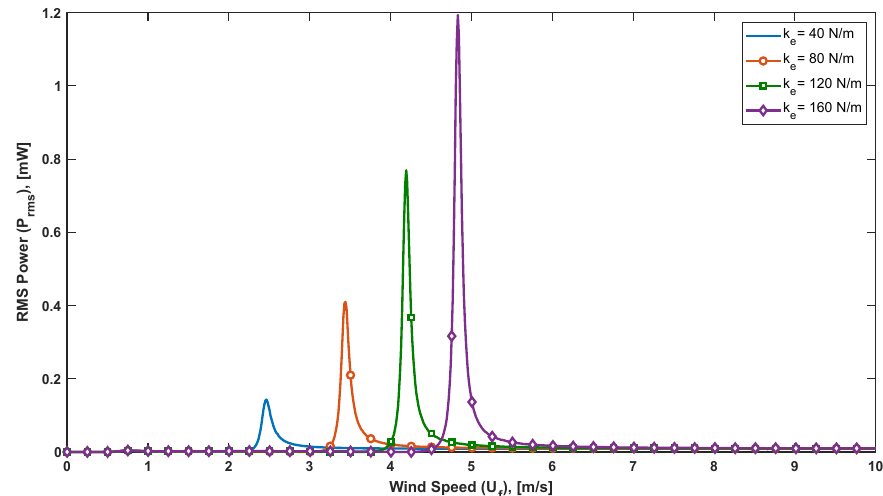
Figure 11. The effect of spring stiffness ( k e ) on harvester output power at different wind speeds.